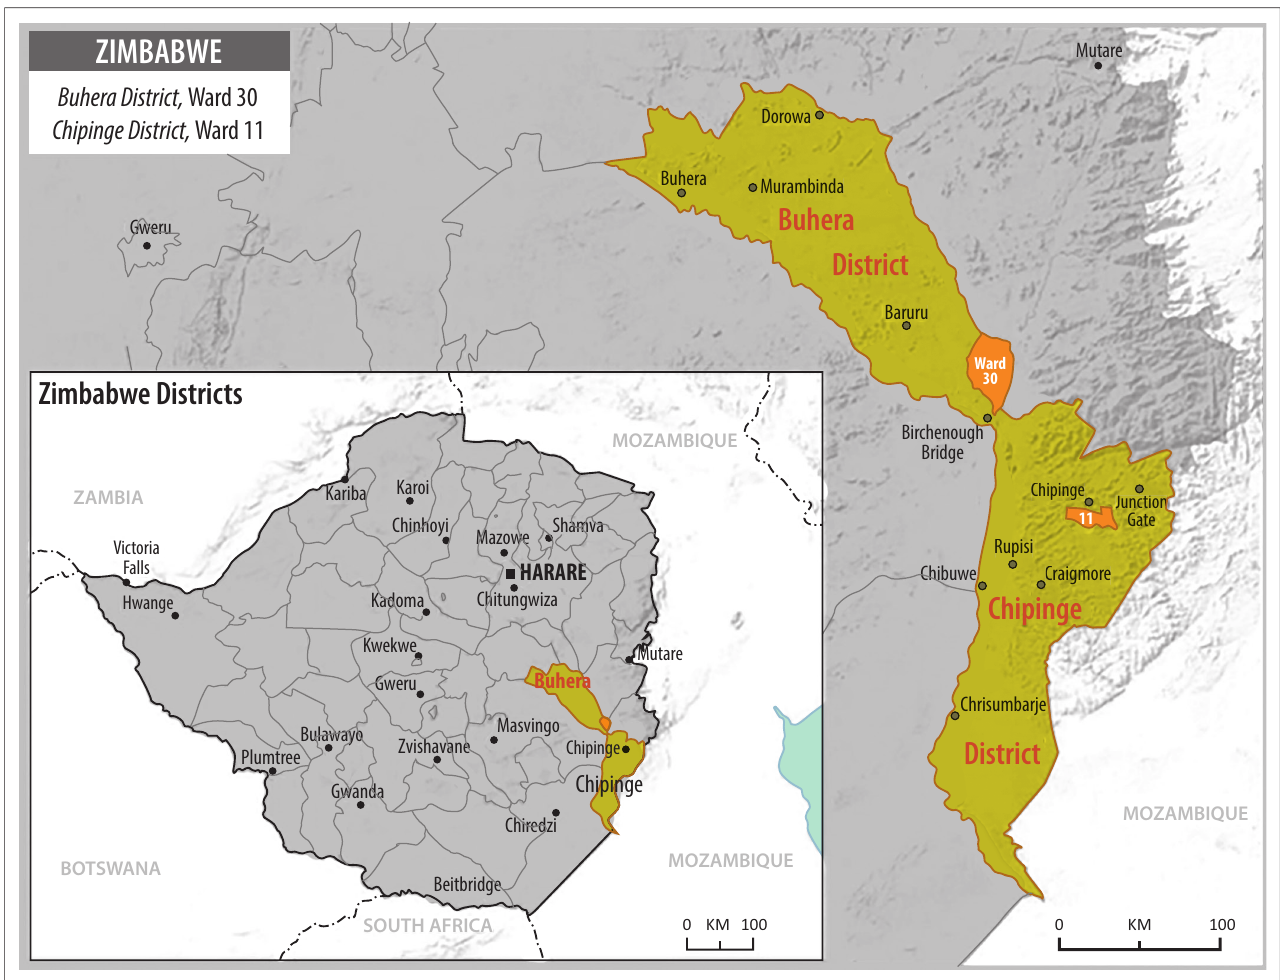
FIGURE 2: Map of Buhera and Chipinge study